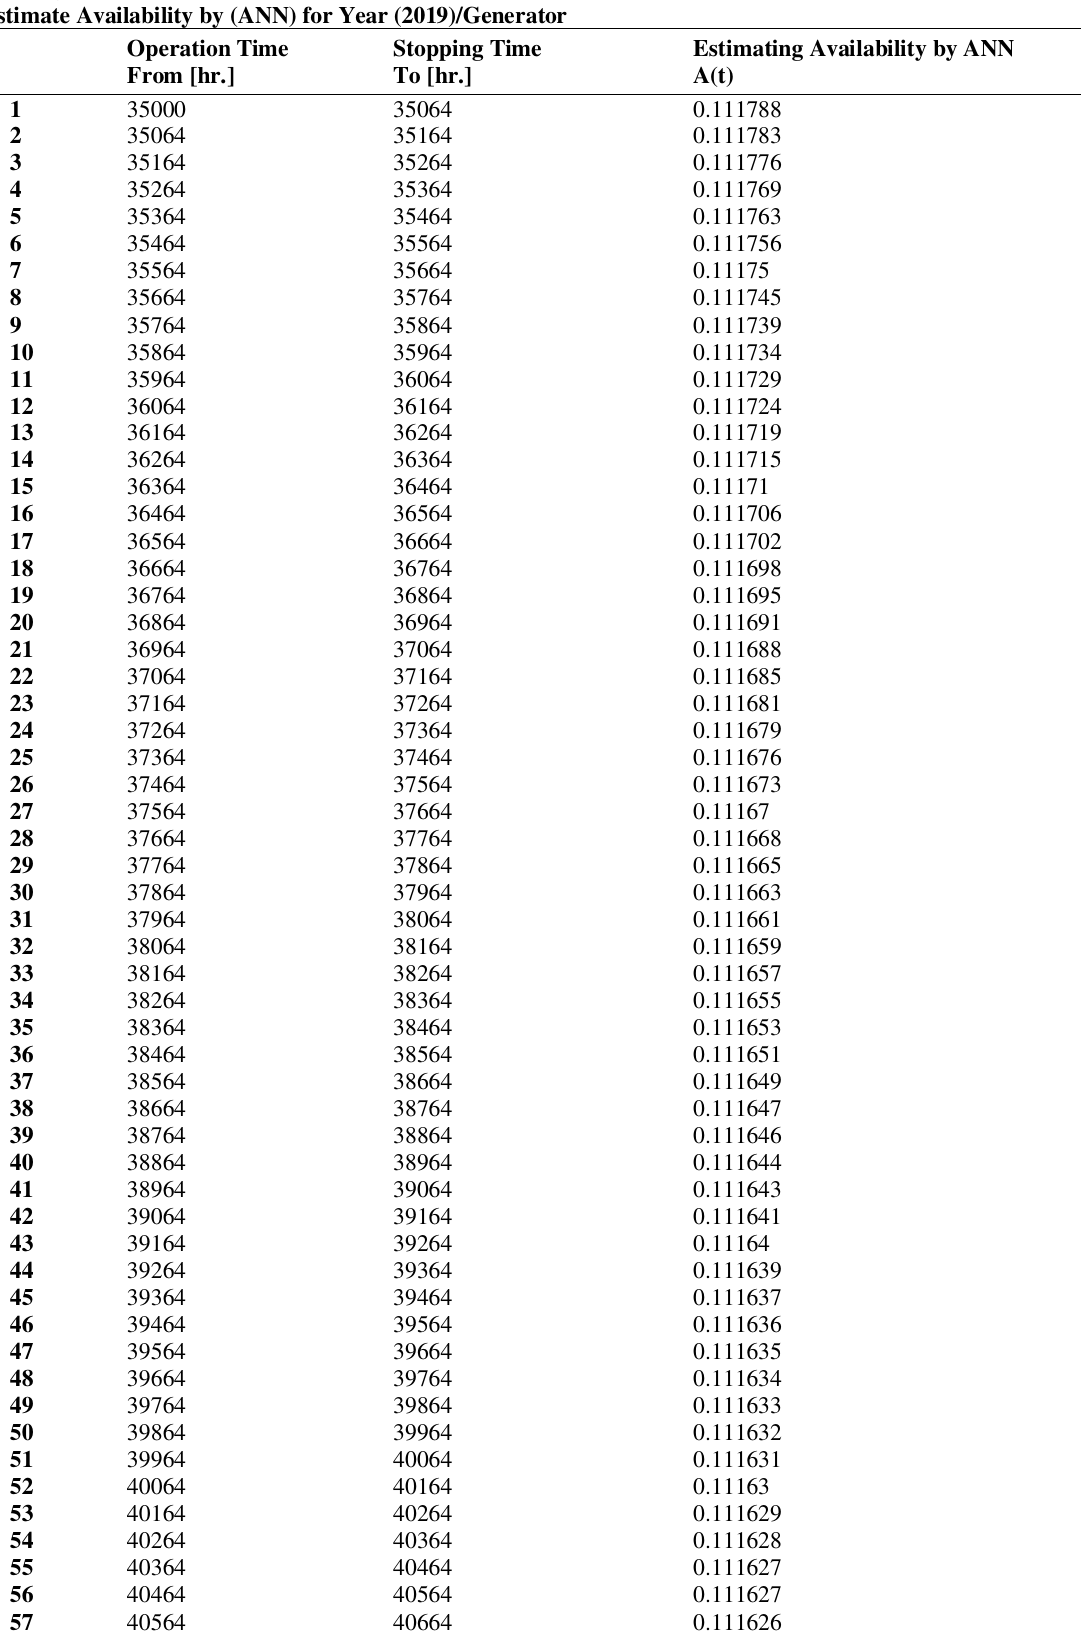
Estimate Availability by (ANN) for Year (2019)/Generator Operation Time From [hr.]